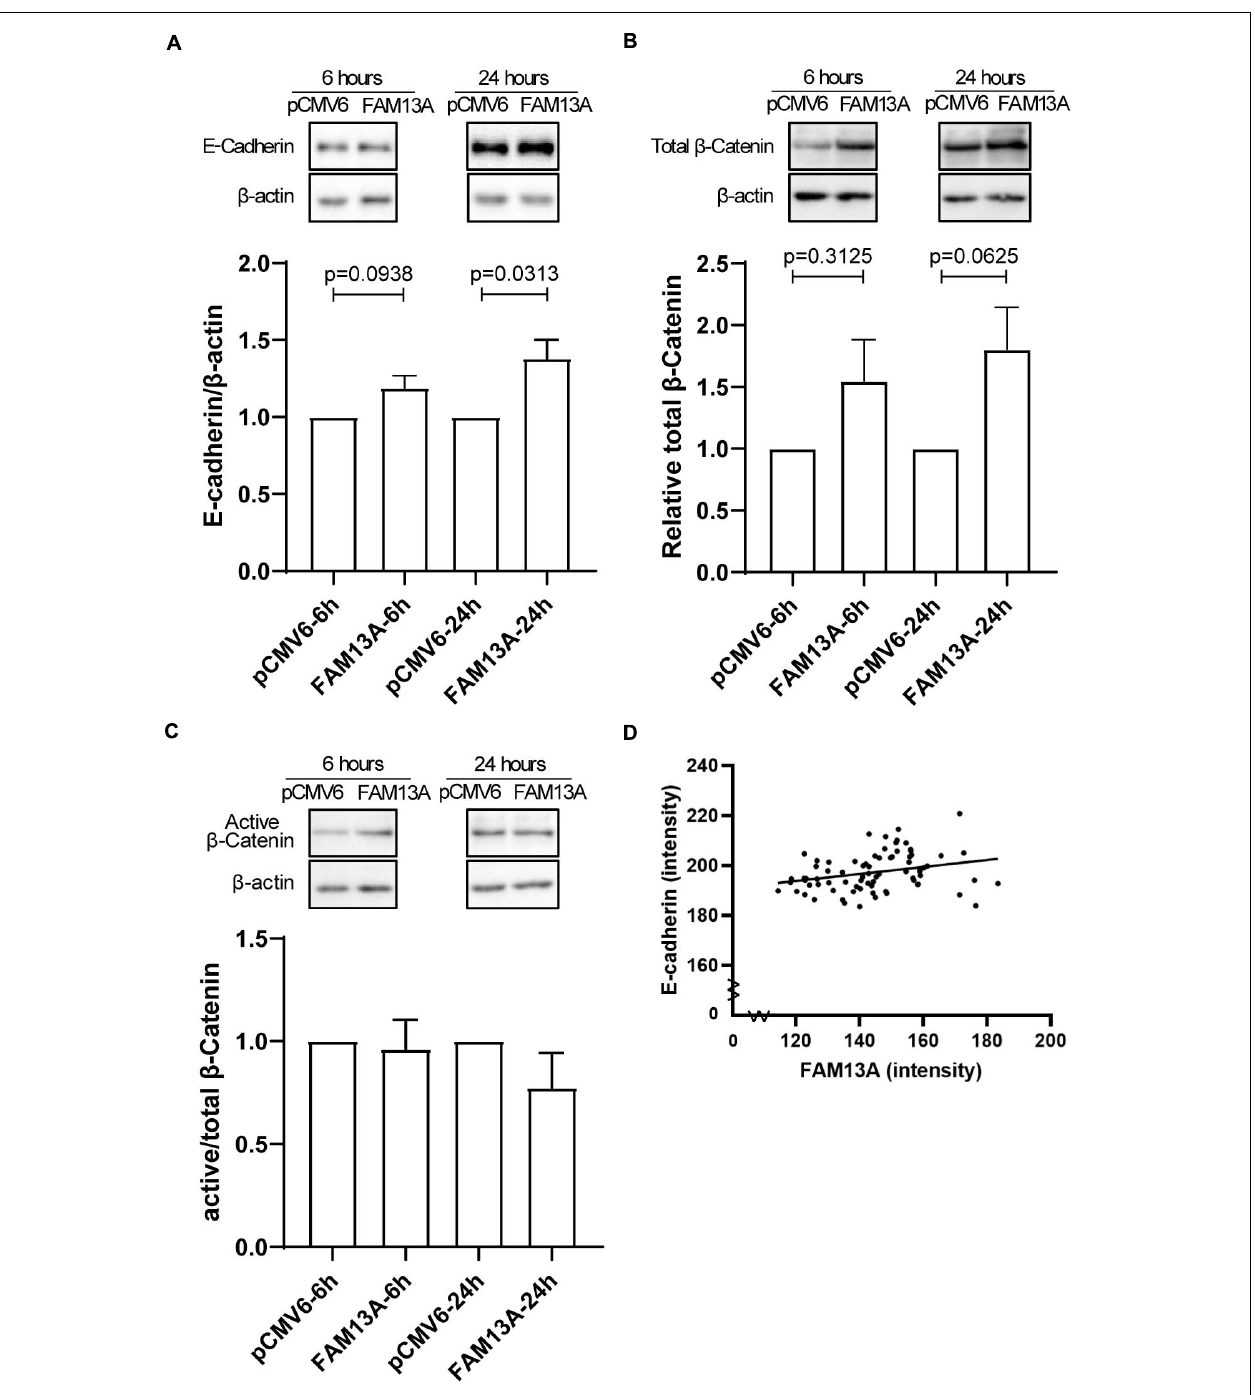
FIGURE 5 | Expression of adherens junction protein E-cadherin is increased upon overexpression of FAM13A in 16HBE14o- cells and correlates with FAM13A in human lung tissue. 16HBE14o- cells were seeded in duplicate, transfected with FAM13A overexpression plasmid or empty vector (pCMV6) and harvested at 6 and 24 h after transfection. (A) E-cadherin protein expression levels were measured using western blot, quantified by densitometry and normalized to β -actin as loading control (mean ± SEM, n = 6). Total β -catenin (B) and active/non-phospho- β -catenin expression levels were assessed by western blot, quantified by densitometry and normalized to β -actin as loading control. (C) The ratio of active/non-phospho- β -catenin to total β -catenin is depicted. Representative blots are shown. Significant differences were assessed by the Wilcoxon signed rank test and the p -value between significant different conditions is as indicated. (D) The expression of E-cadherin in human lung tissue was assessed by immunohistochemistry comparable to FAM13A as described above. The correlation between the expression of FAM13A and E-cadherin in the same airway was tested using the Pearson’s correlation test. Each dot represents one airway. Number of data pairs = 77, r = 0.2812, p = 0.0132.